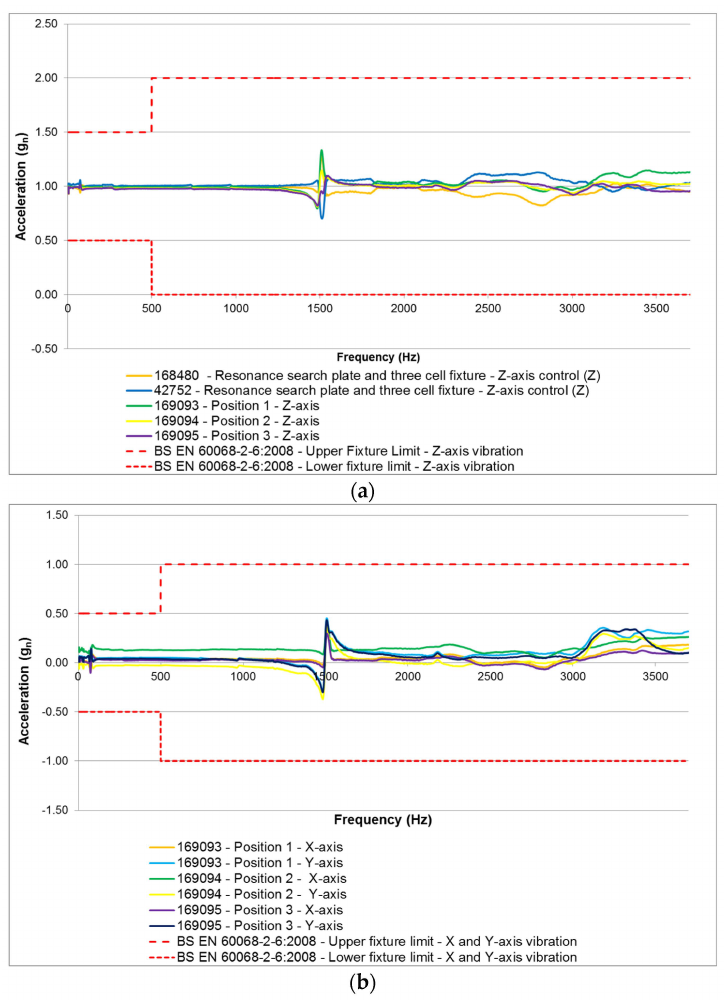
Figure 5. BS EN 60,068 Resonance evaluation of resonance search plate ( a ) Z-Axis of search plate ( b ) X and Y-Axis of search